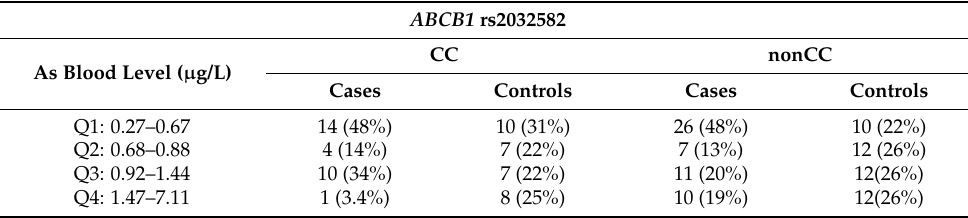
Table 4. Numbers of CRC cases and healthy controls depending on ABCB1 gene polymorphism and blood-As concentration in women. ABCB1 rs2032582 CC nonCC As Blood Level ( µ g/L) Cases Controls Cases Controls